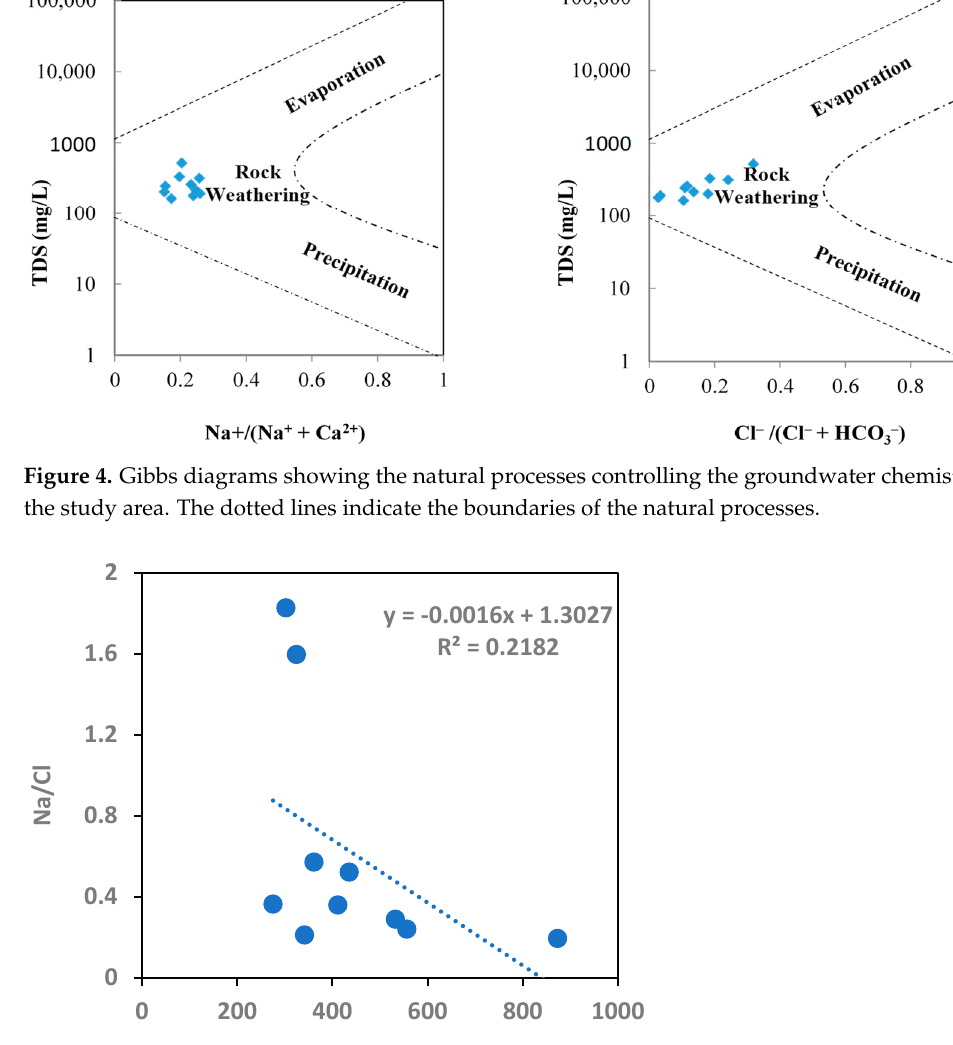
Figure 3. The Piper diagram showing the water types in the study area.